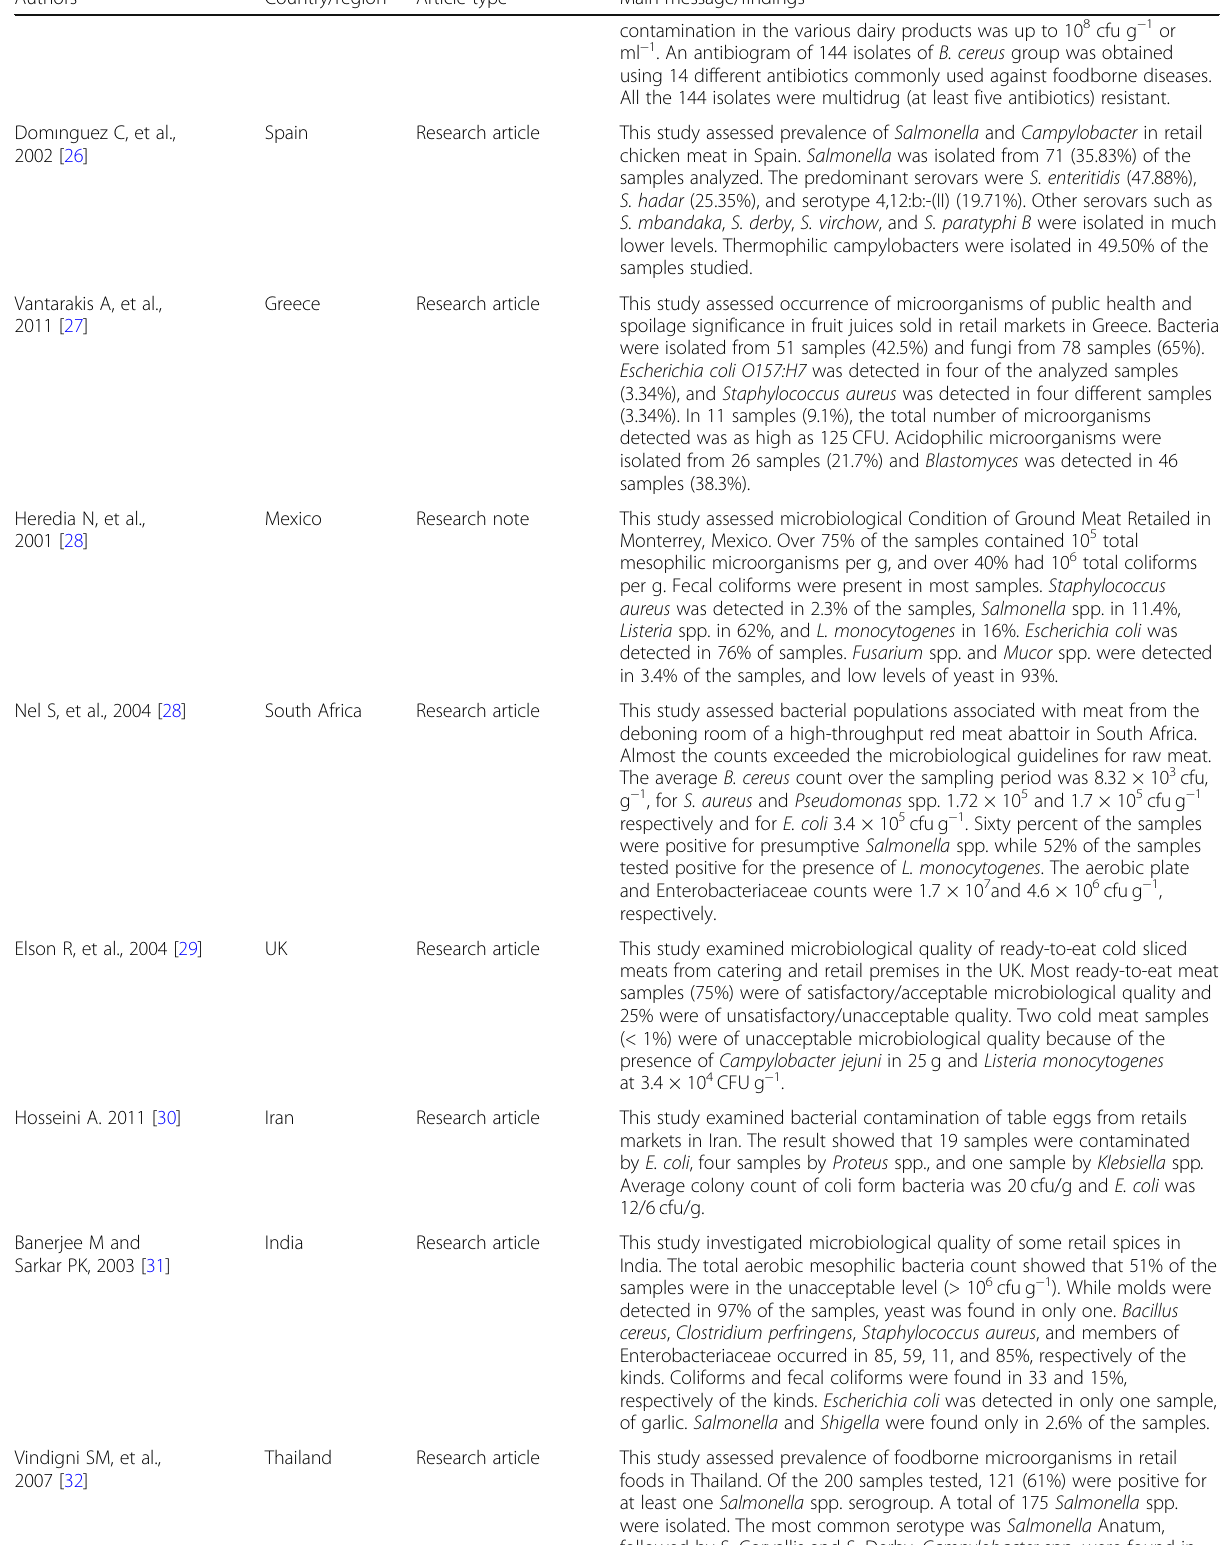
Table 3 Summary of full-text articles which reported microbial contamination of foods as a public risk in food marketing